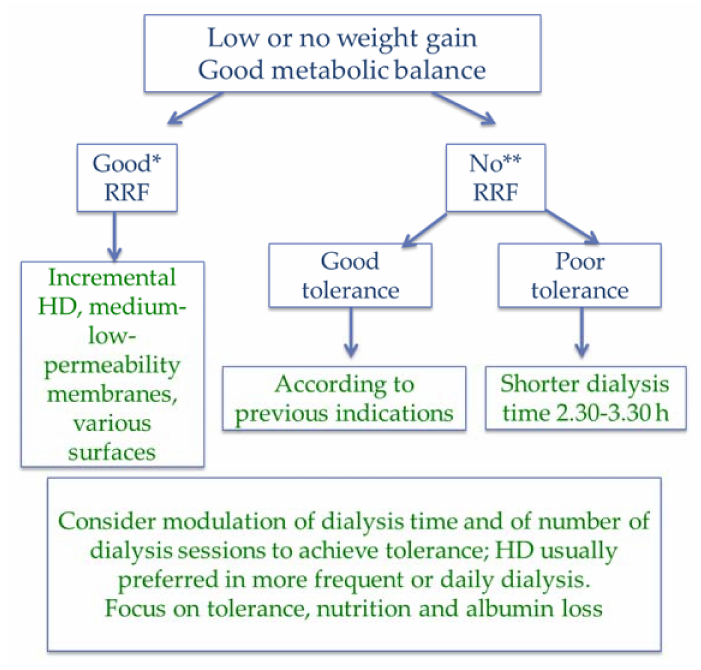
Figure 6. Short and incremental dialysis: “soft is best”. Good RRF (*): urine output arbitrarily defined as at least 750 mL/day, according to body surface. Survival advantage is reported for residual diuresis >250 mL/day [130–132]. No significant RRF (**): arbitrarily defined as urine output less than 500 mL. RRF measure: creatinine clearance or average urea and creatinine clearance (clearance 6–10